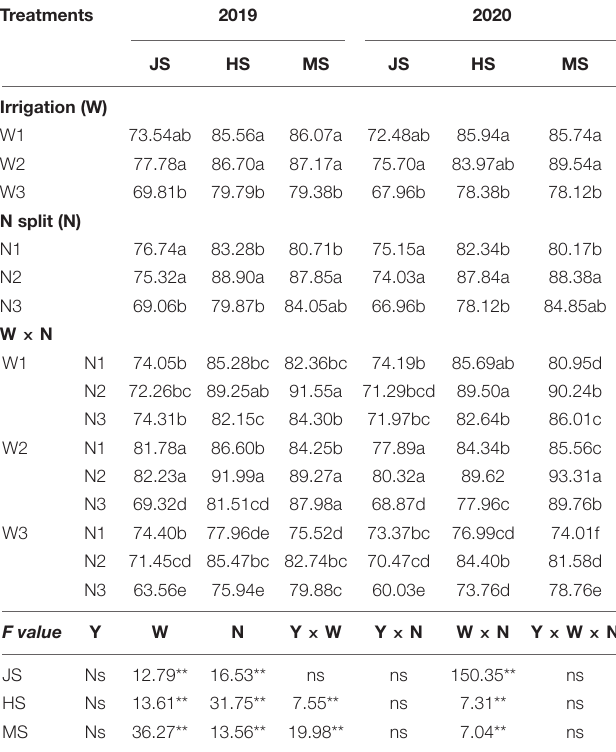
TABLE 5 | Effect of the irrigation methods and N split applications on leaf relative water content (RWC).